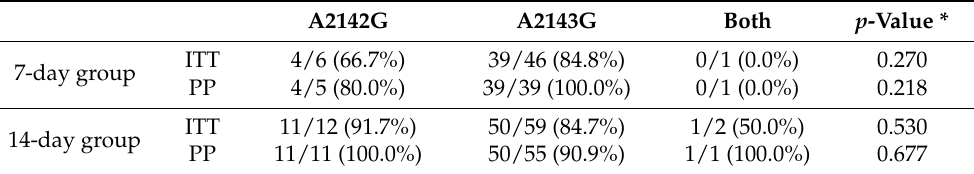
Table 3. Eradication rates of the two study